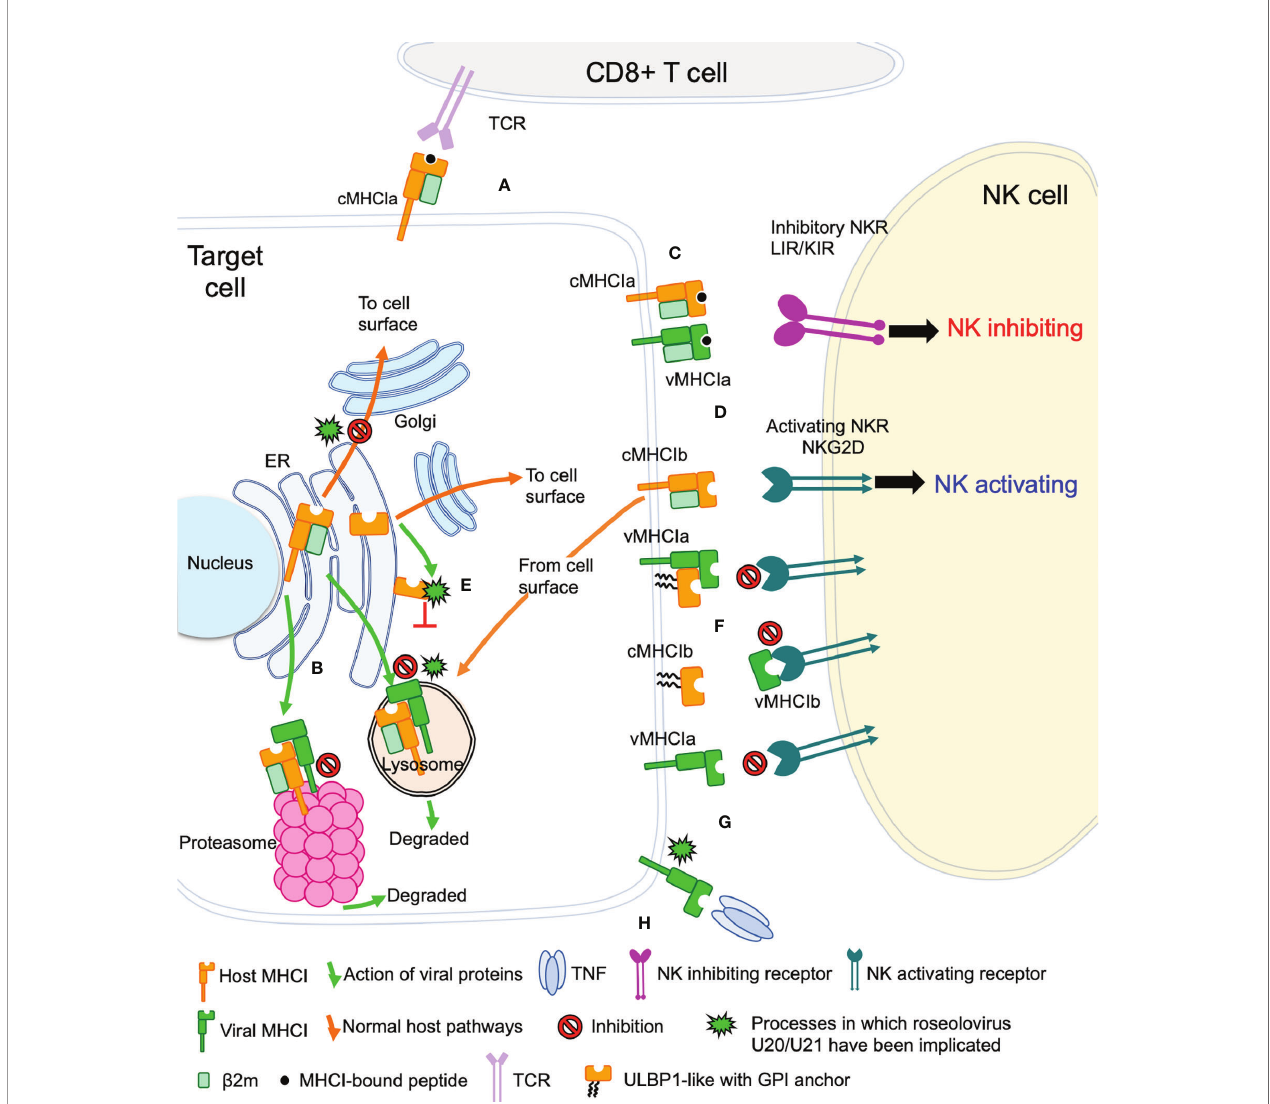
FIGURE 2 | Viral evasion of T cell and NK cell recognition. Viral MHC-based immune evasion pathways employed by betaherpesviruses and poxviruses are shown. MHC- Ia refers to classical polymorphic peptide-binding class I MHC molecules, MHC-Ib refers to non-classical non-polymorphic class I MHC homologs that do not present peptides. cMHC-Ia and cMHC-Ib refer to cellular (host) protein, vMHC-Ia and vMHC-Ib refer to viral homologs. Other mechanisms employed by betaherpesviruses and poxvirus to evade T cell and NK cell recognition involve interference with antigen processing, transcriptional regulation, and innate immune evasion, but those pathways are not known to involve vMHC-I molecules and are not included here. (A) cMHC-Ia present peptides to CD8+ T cells, triggering induction of cytolytic pathways upon T cell receptor (TCR binding). (B) vMHC-Ib block this pathway by redirecting cMHC-Ia to proteasomes or lysosomes for destruction. (C) Inhibitory natural killer cell receptors (NKR) can recognize the loss of surface cMHC-Ia as part of the “ missing-self ” recognition system. vMHC-Ia combat this by engaging inhibitory NKR. (D) NK cells sense cellular stress using activating NKR to recognize stress-induced cMHC-Ib proteins. (E) vMHC-Ib block this pathway by redirecting cMHC-Ib to proteasomes or lysosomes for destruction. (F) vMHC-Ib can block activating NKRs by either masking them on the surface or by secreting vMHC-Ib variants that can engage activating NKR and competitively block recognition of cMHC-1b stress ligands. Wavy lines indicate glycosylphosphatidylinositol (GPI) membrane anchors used by some ULBP proteins instead of transmembrane helices. (G) Paradoxically, vMHC-Ib can engage activating NKR for reasons that remain poorly understood. (H) Another vMHC-Ib binds the in fl ammatory cytokine TNF a , sequestering it from productive engagement with